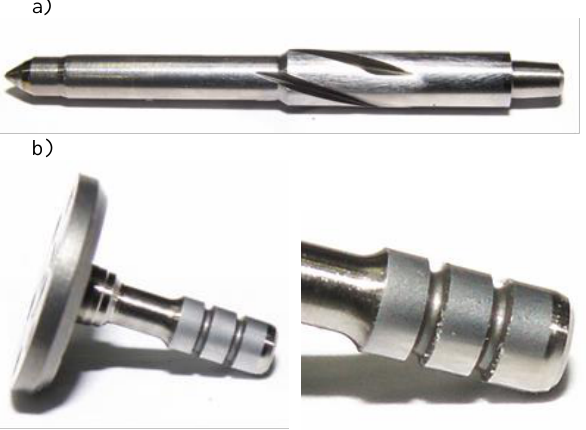
Fig. 4. Traces of mechanical damage originated from the impact of hard particulate contaminations acting on the working parts of a) injector nee-